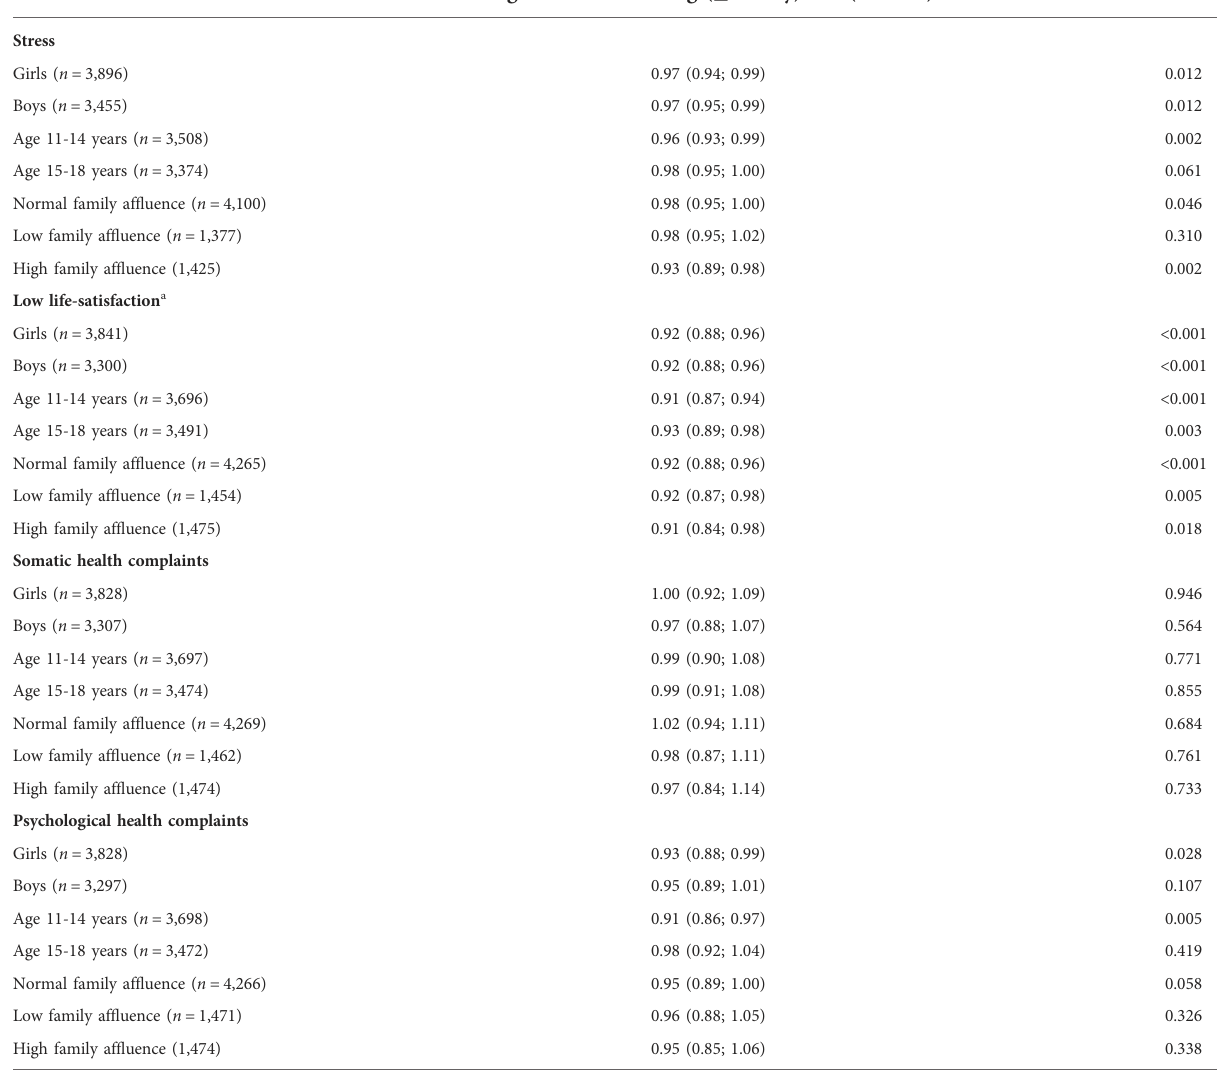
Regular toothbrushing ( ≥ 2 daily) OR (95%